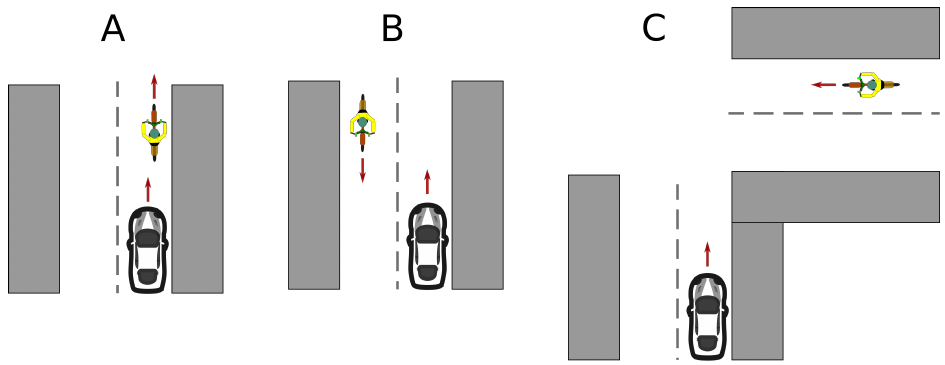
Figure 17. Scenarios to validate the alarm system. ( A ) both vehicles traveling in the same direction. ( B ) vehicles traveling in the opposite direction. ( C ) vehicles meeting at a 90 ◦ road crossing.